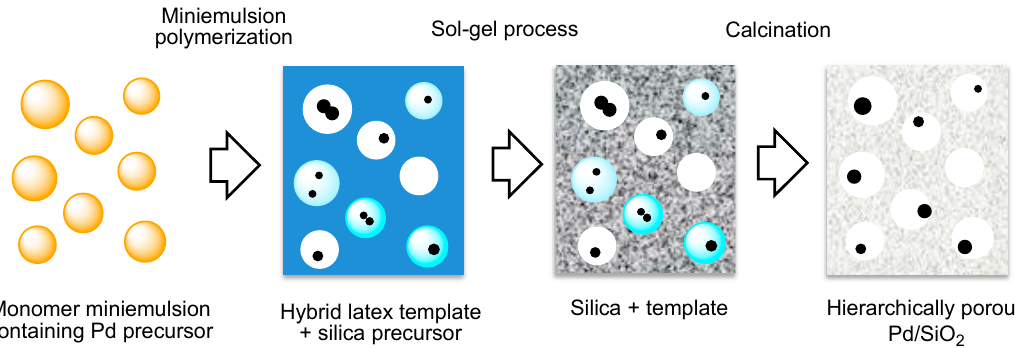
Figure 10. A schematic reprentation of the synthetic protocol for the preparation of hierarchically porous Pd/SiO 2 catalysts.